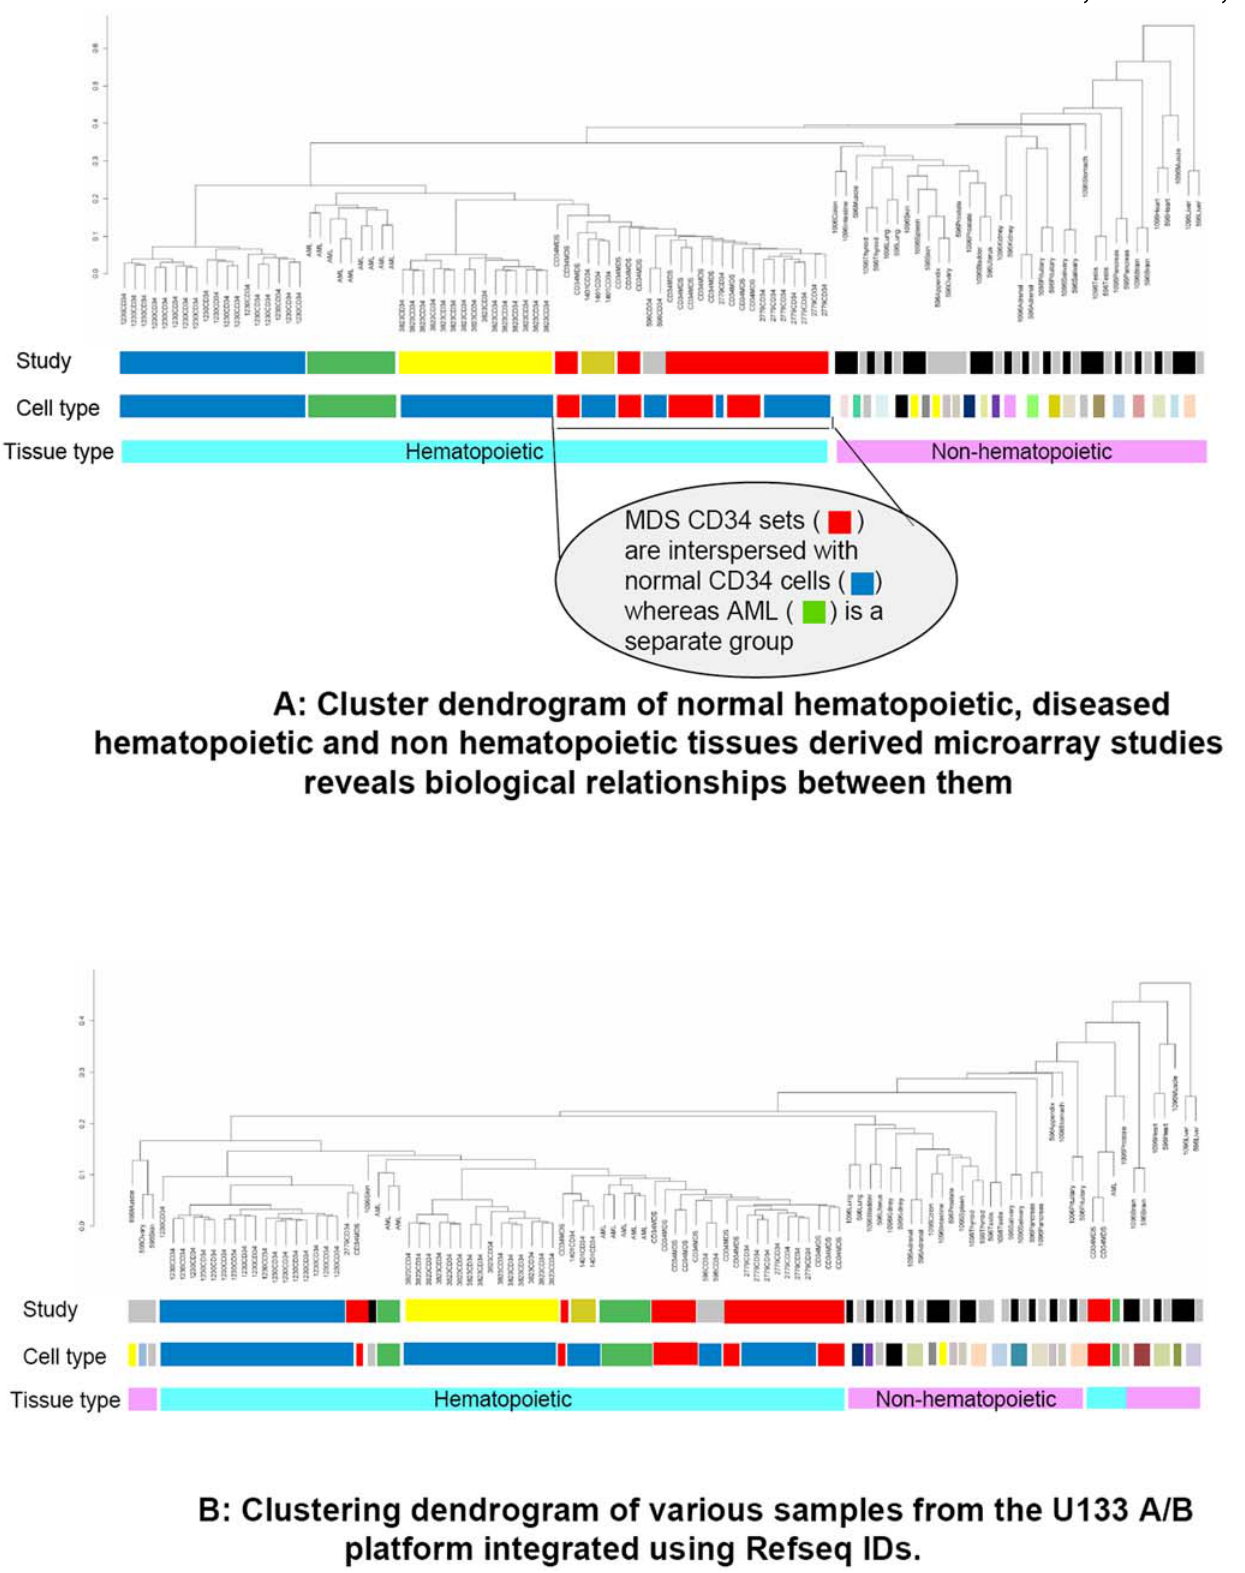
Figure 4. A: Biological relationships identified. Dendrogram of normal hematopoietic, diseased hematopoietic and non hematopoietic tissues GE profiles reveals biological relationships between them. MDS sets intersperse with normal hematopoietic tissues whereas AML samples are a separate group, exactly as their biological dissimilarity patterns. Dendrogram based on unsupervised hierarchical clustering, using (1 - Pearson correlation coefficient) as the distance measure. Same color in each horizontal row indicates same group. UniGene IDs were used for integrating data. B: Clustering using RefSeq IDs. Same clustering as in 4A, showing poorer performance of RefSeq IDs, compared to UniGene IDs, in uncovering biological relationships. Dendrogram based on unsupervised hierarchical clustering, using (1 - Pearson correlation coefficient) as the distance measure. Same color in each horizontal row indicates same group. doi:10.1371/journal.pone.0002965.g004 PLoS ONE |